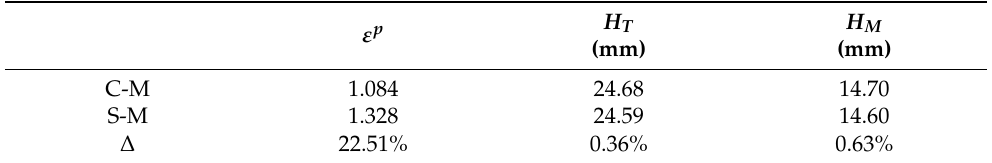
Table 7. Comparison between the complete model (C-M) and simplified model (S-M) for dynamic shear test.